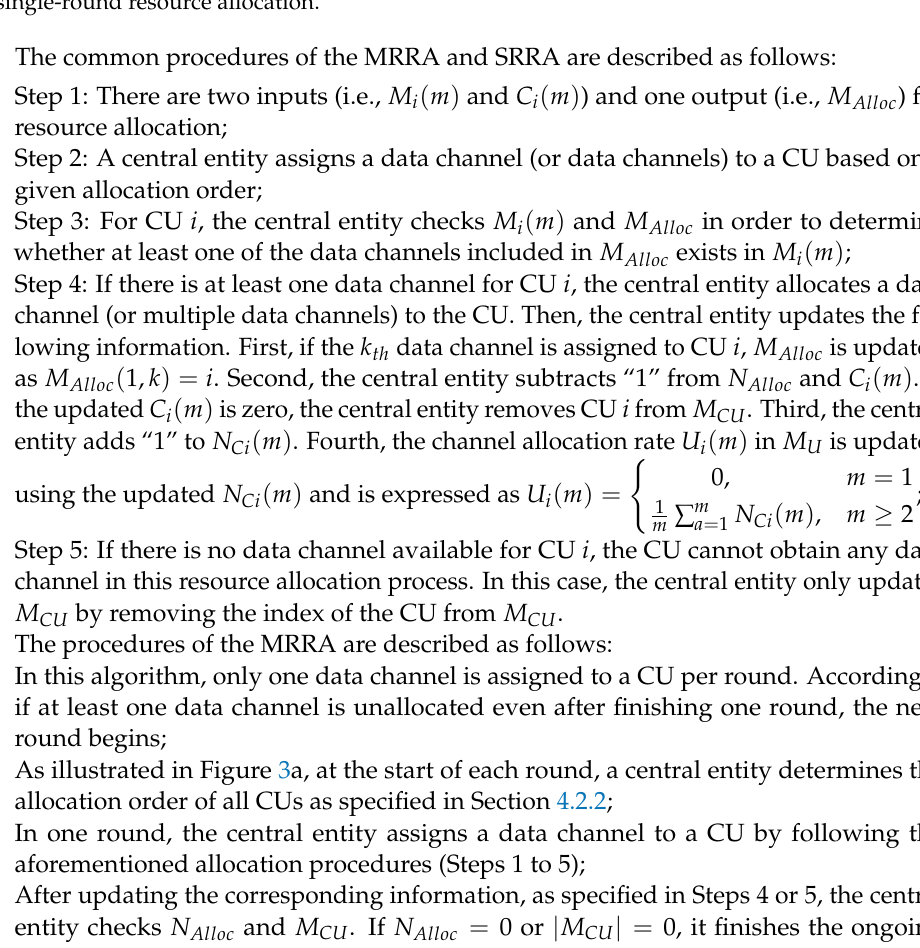
Figure 3. A flow chart of the resource allocation algorithms: ( a ) multiround resource allocation and ( b ) single ‐ round resource allocation.